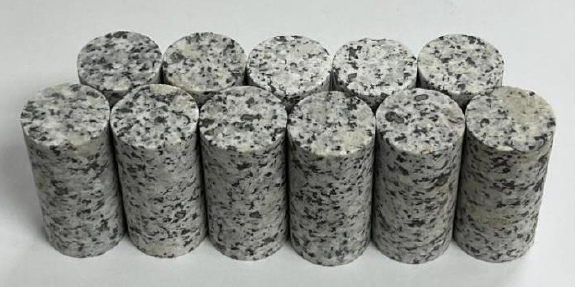
Figure 2. Granite samples in the Sanguliu pluton of the Liaodong